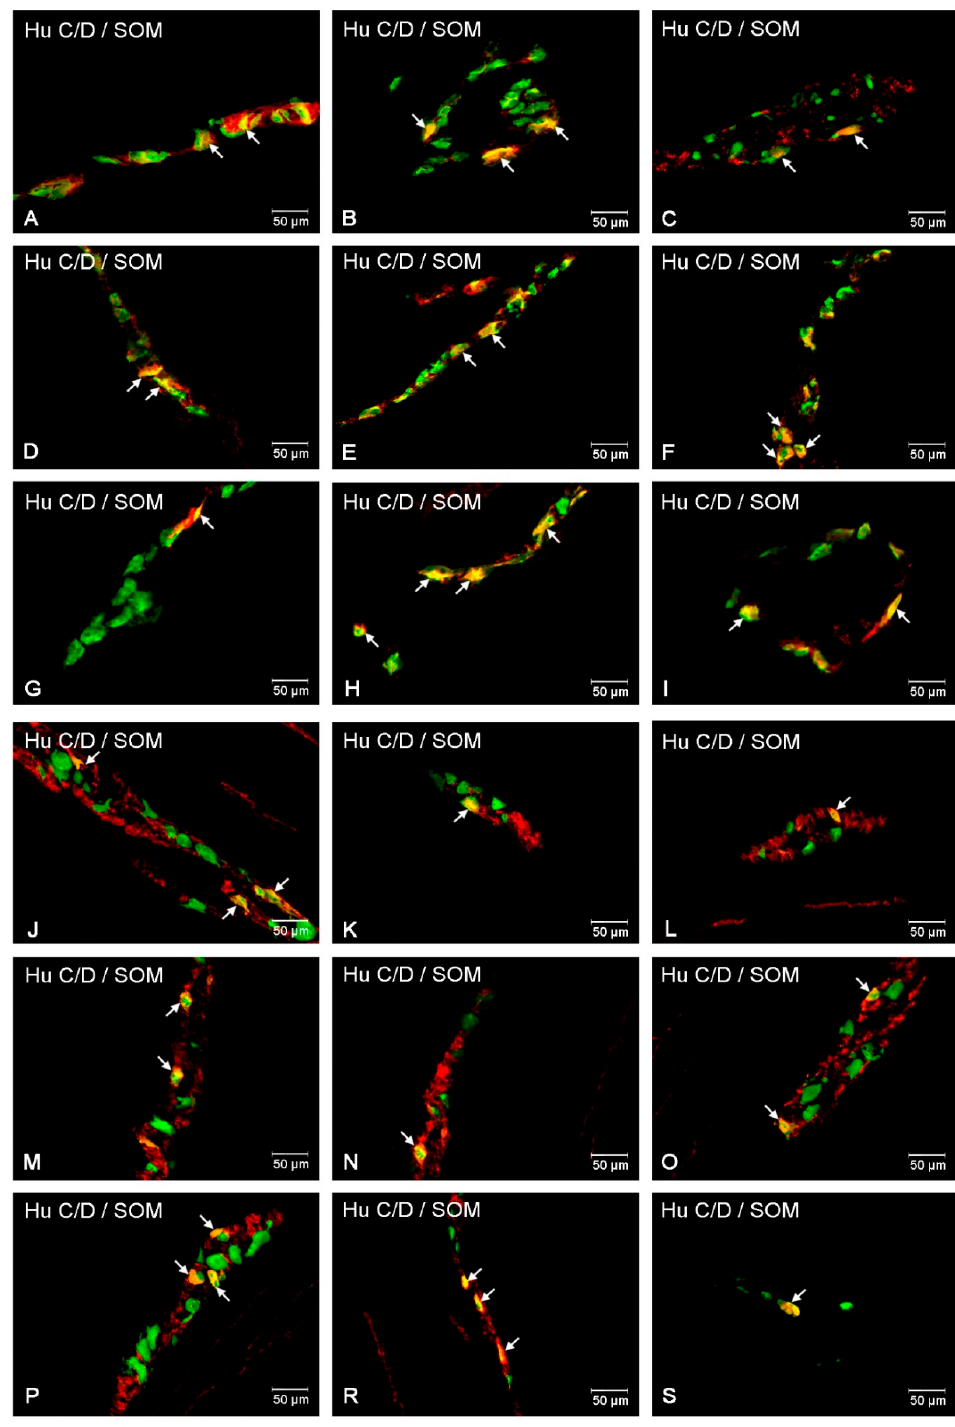
Figure 5. Intramural plexuses in the small intestine immunoreactive to SOM. Myenteric plexus of duodenum ( A , D ), jejunum ( B , E ), and ileum ( C , F ) under physiological condition ( A – C ), and of hyperglycemic animals ( D – F ). Outer submucosal plexus of the duodenum ( G – J ), jejunum ( H – K ), and ileum ( I – L ) under physiological state ( G – I ) and after streptozotocin injection ( J – L ). Inner submucosal plexus of the duodenum ( M ), jejunum ( N ) and ileum ( O ) under physiological condition ( M – O ) and after streptozotocin administration ( P – S ). All photographs were created by digital superimposition of two color channels (green for Hu C/D used here as a pan-neuronal marker, and red for SOM). Neurons showing co-localization of Hu C/D and SOM are indicated with arrows.